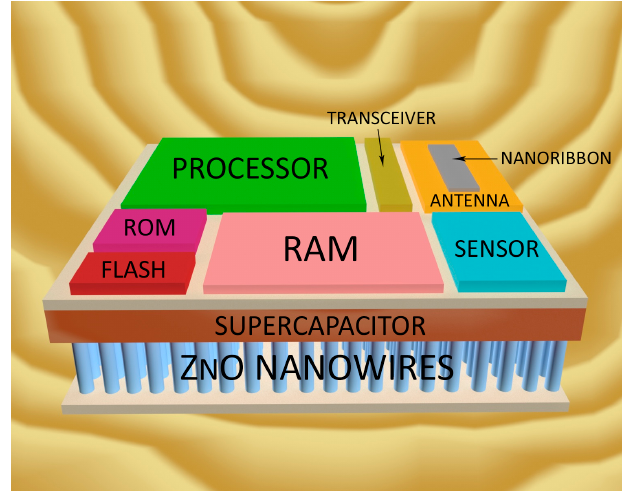
Figure 2. Nanodevice—a general view of our proposal.